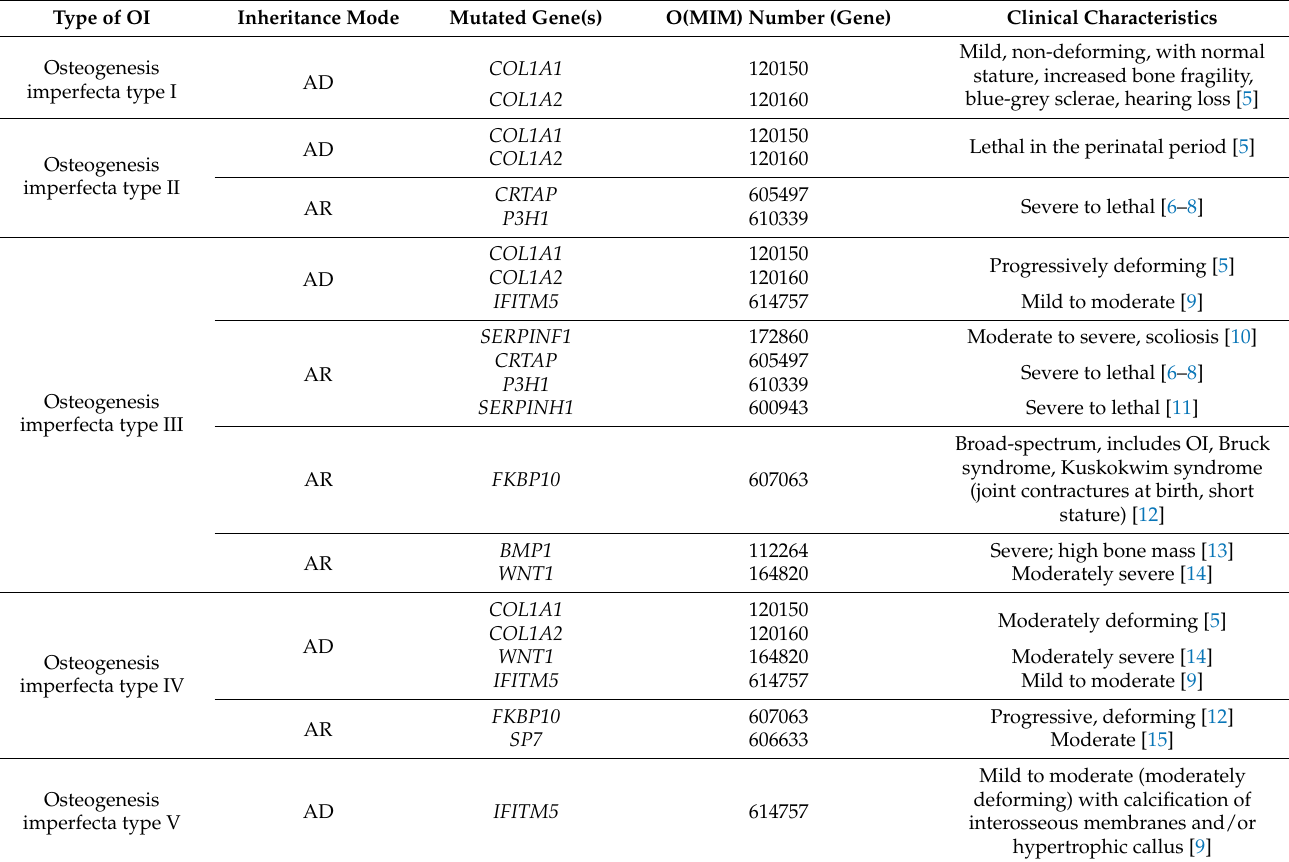
Table 1. Classification of OI